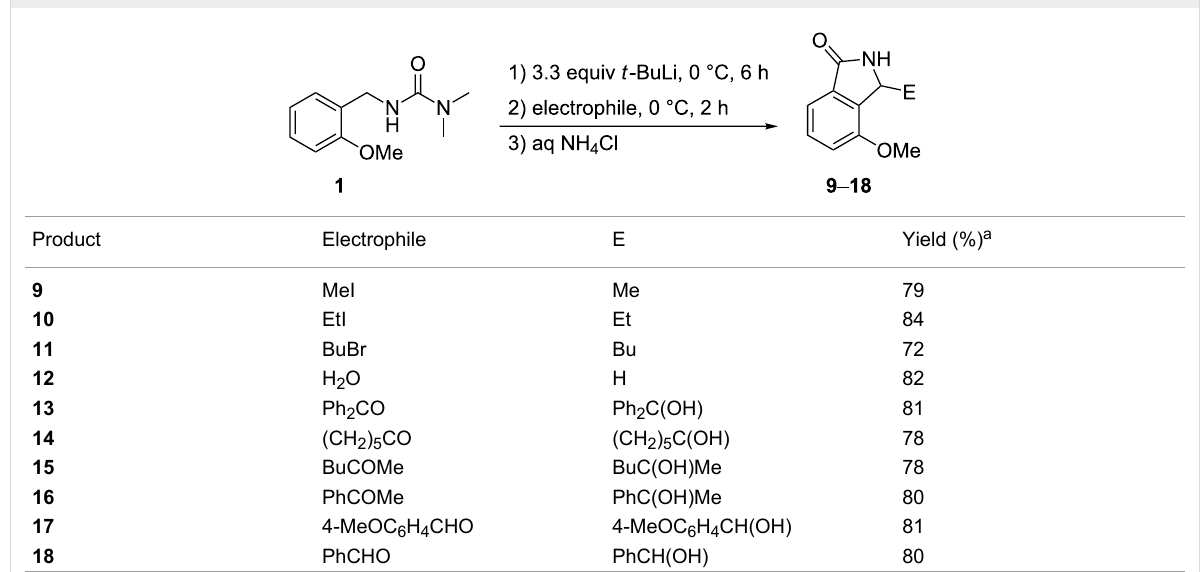
Table 1: Synthesis of 3-substituted 4-methoxyisoindolin-1-ones 9 – 18 .